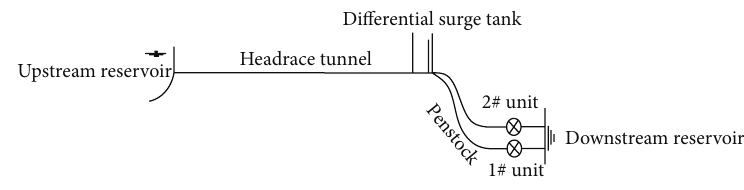
Figure 3: Layout of the waterway and power generation system of the hydropower